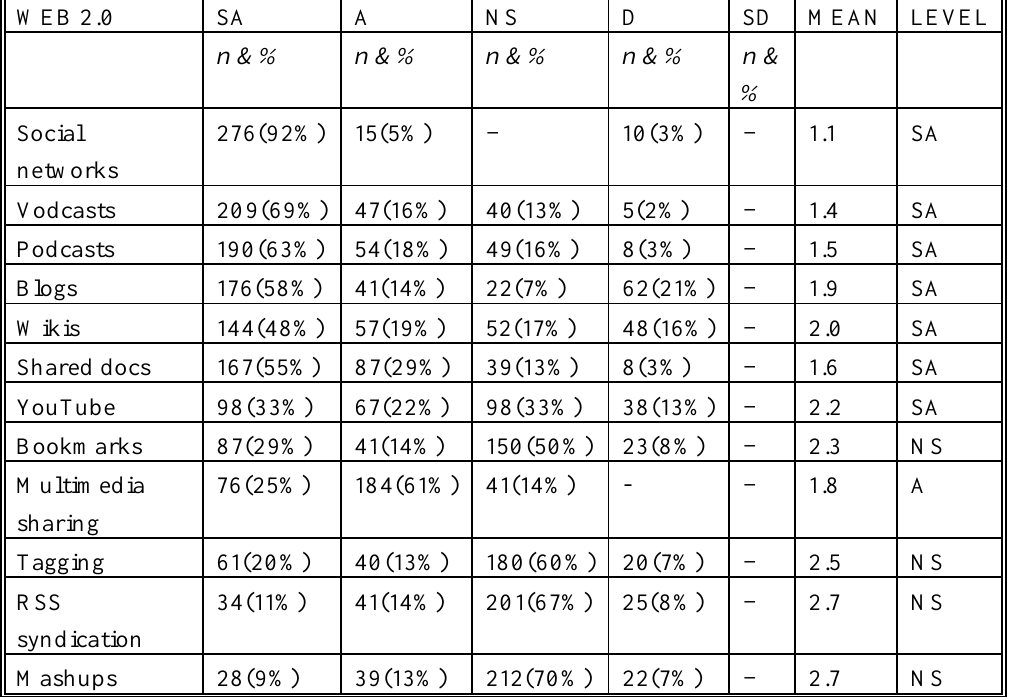
Essential Elements of Cooperative Learning (N = 301) WEB